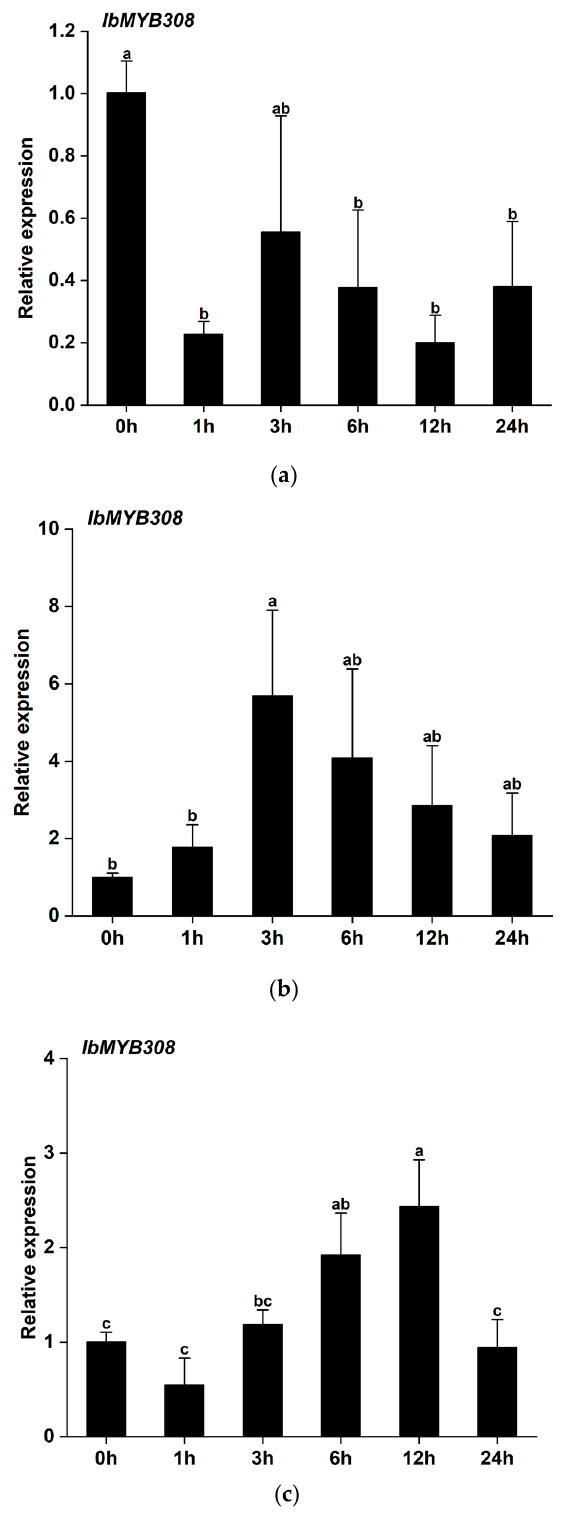
Figure 4. Expression profiles of IbMYB308 in response to abiotic stress treatments. Sweet potato under ( a ) 20% PEG-6000, ( b ) 200 mM NaCl, and ( c ) 20% H 2 O 2 . IbActin was used as an internal reference gene. Data are presented as the means of three biological replicates ± SD ( n = 3 ). Error lines indicate standard deviations. Different lowercase letters (a–c, ab, bc) on the bars indicate significant differences at p <